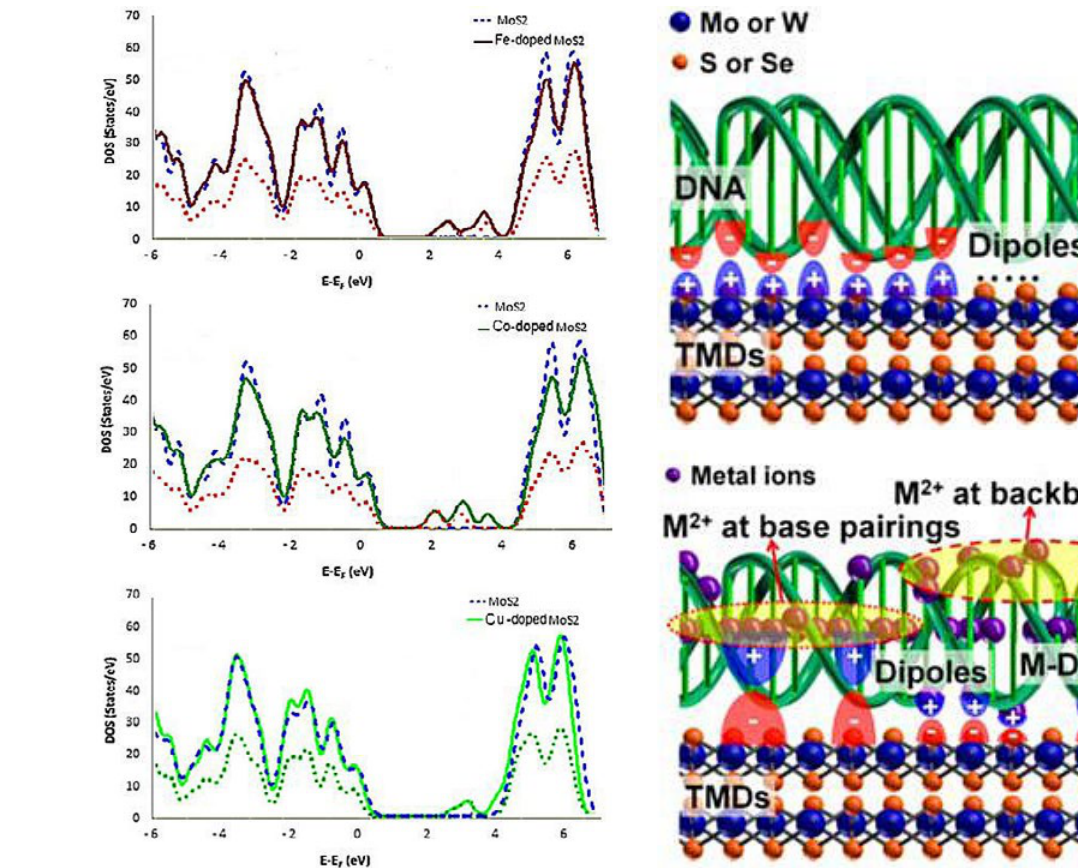
Fig. 4. Total densities of states (DOS) of pristine MoS MoS . [( a ) Fe, ( b ) Co, ( c ) Ni, and ( d ) Cu]. 2